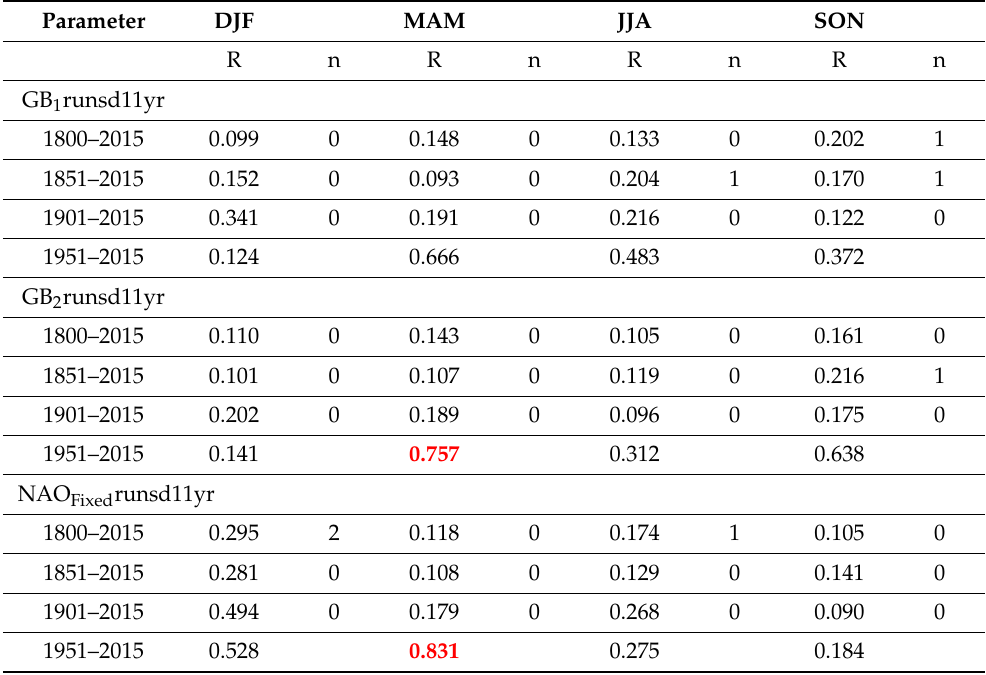
Table 2. Mean correlation coefficients (R) and number of ensemble members with significant trends (n), based on individual analysis of all 30 ensemble members of EKF400v2 (1800–1949) spliced with ERA5 (1950–2020), of trends in 11-year running standard deviation of GBI and NAO for the entire records and various sub-periods. Other details are as stated in the Table 1 caption. In assessing statistical significance, degrees of freedom were scaled by the smoothing interval (i.e., number of years minus two were divided by eleven). Significant upward temporal overall trends, determined based on reference [74], with the corre-sponding number of significant ensemble trends, are emboldened in